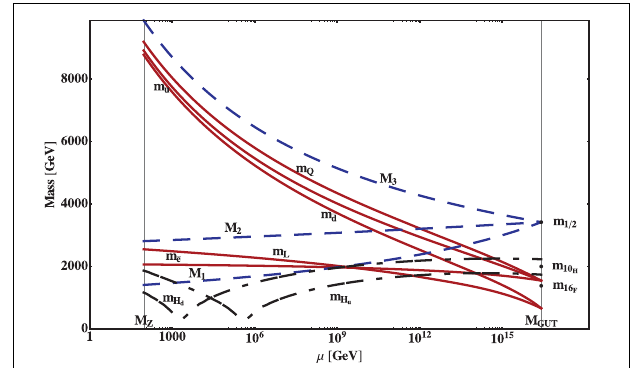
FIGURE 3 | Solution of the RGEs for the scalar masses of the 1st generation, the gaugino masses and the Higgs doublet masses in the benchmark scenario defined in Equation (9) but with m 2 = (2 TeV ) 2 and m 2 10 H